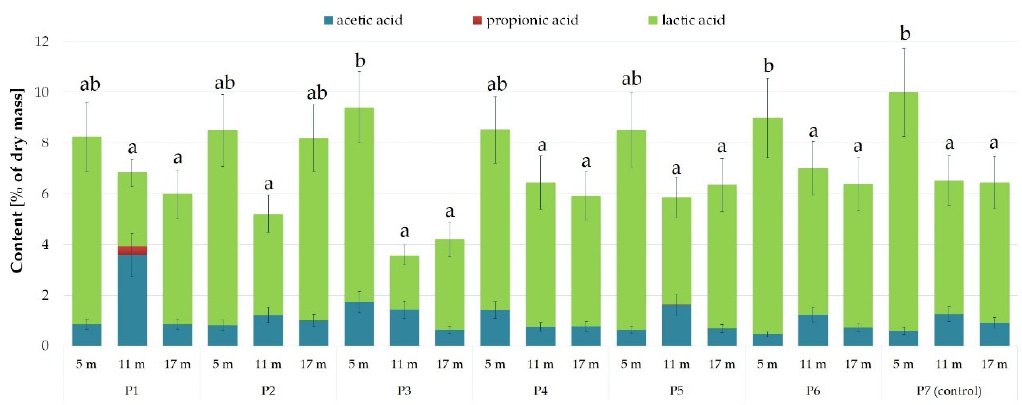
Figure 6. Changes in organic acid content in silages stored for 5, 11 and 17 months. Bars marked with the same letters indicate no statistical difference ( p < 0.05); statistical significance analysis was performed for the sum of organic acids. Table 2. Silage parameters (the average content in DM). Values marked with the same letters indicate no statistical difference ( p < 0.05); results were analyzed separately for each